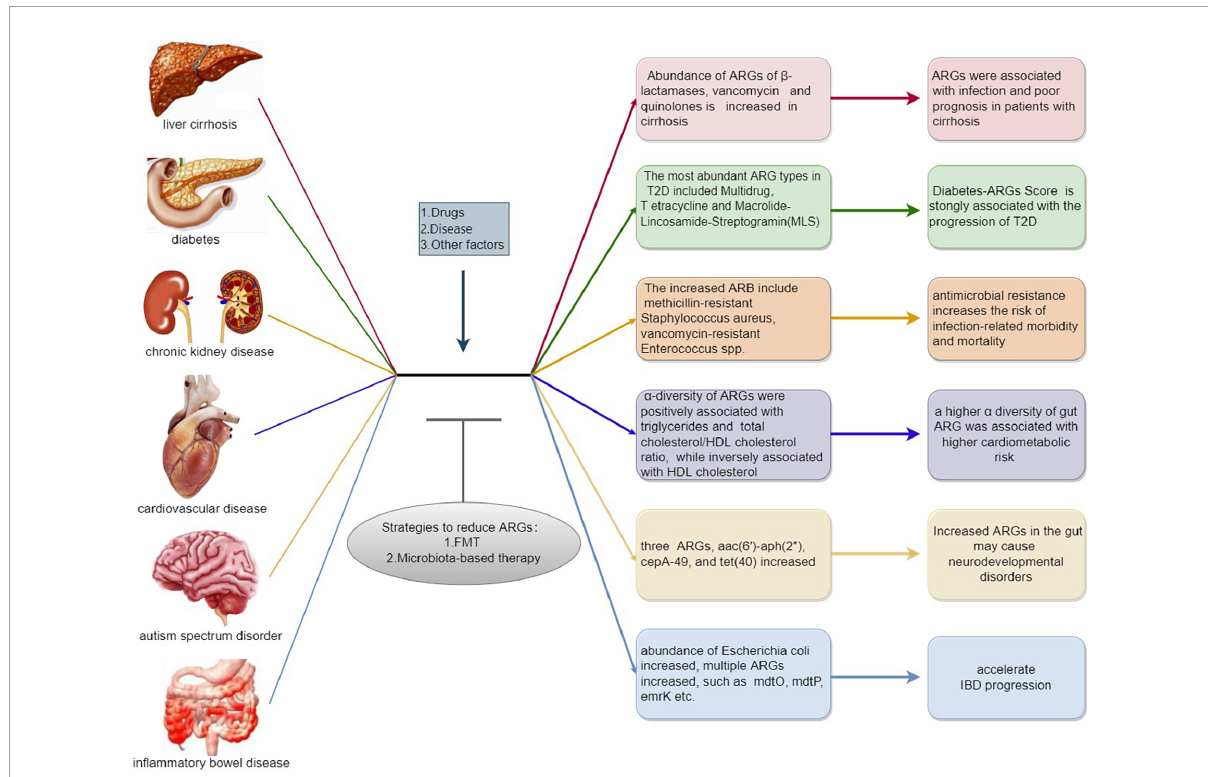
FIGURE2 A brief introduction of antibiotic resistance genes (ARGs) in common chronic diseases. Exogenous and endogenous stimulation such as drugs and chronic diseases are positively correlated to the emergence and expansion of ARGs, which may conversely aggravate the progression of chronic diseases. While microbial intervention including fecal microbiota transplant, prebiotic and probiotic exhibit the potential to downregulate the abundance of ARGs which may improve related